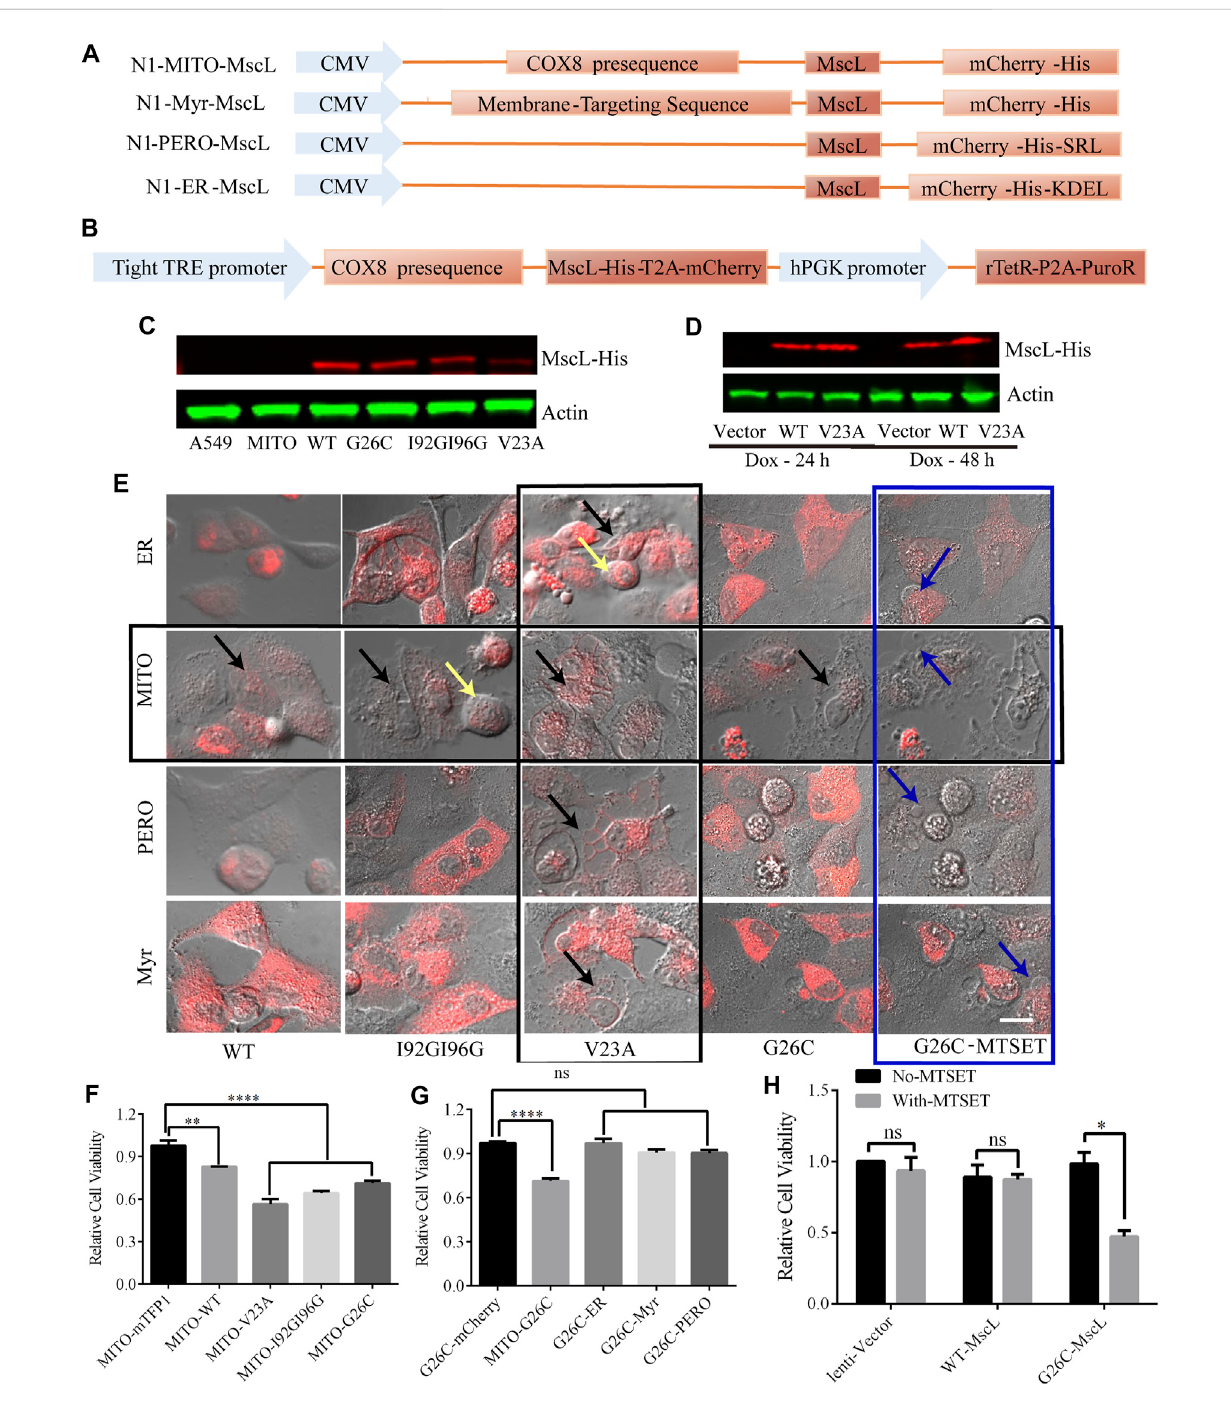
Subcellular expression and doxycycline-inducible expression of MscL channels in A549 cells. (A) Graphical representation of the vector constructs of expressing MscL in different subcellular localizations. (B) Graphical representation of the vector constructs of expressing MscL in doxycycline (dox) inducible lentiviral system. (C) and (D) Western blot detection of MscL-His of transiently expressing MITO-located MscL and doxycycline-induced stably expressing MITO-located MscL in A549 cells. (E) Morphology of control and MscL-mCherry expressing cells when MscL channels were located in subcellular sites of ER, MITO, PERO, and cell membrane, yellow, black, and blue arrows indicate cell swelling, cytoplasmic vacuolization and membrane blebbing, respectively. (F) and (G) Summary of cell viability of A549 cells transfected with different MITO-located GOF-MscL channels and different subcellular localizations of G26C-MscL by MTT assay (mean ± SEM, ** p < 0.01, **** p < 0.0001, ns: no signi fi cance). (H) MTT assay detected the effect of MTSET on lentivirus stable cell lines of A549, (mean ± SEM, * p < 0.05, ns: no signi fi cance). Scale bar: 10 μ